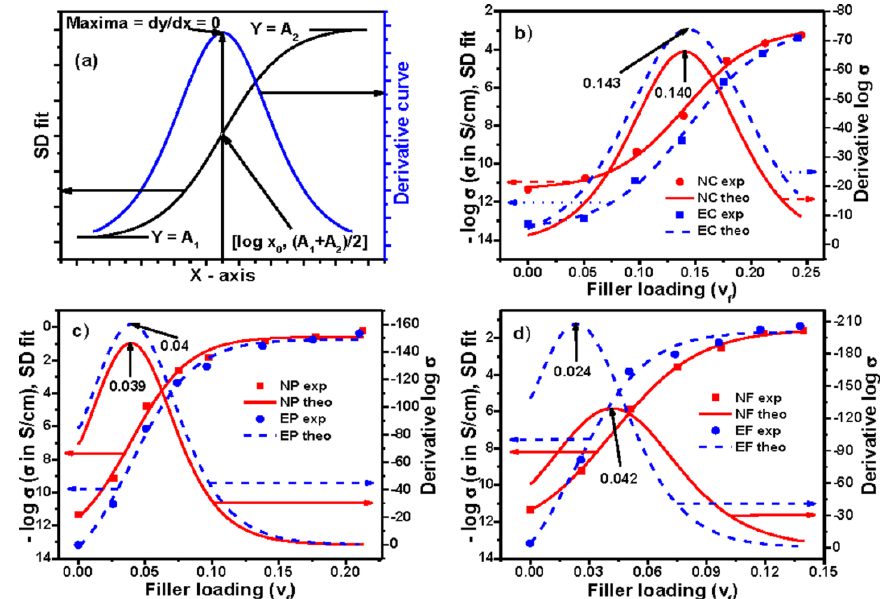
Figure 5. Experimental, theoretical, and derivative curves: ( a ) an ideal curve; ( b ) Conductex black filled; ( c ) Printex black filled; and ( d ) SCF filled composites based on Sigmoidal–Dose Response model.